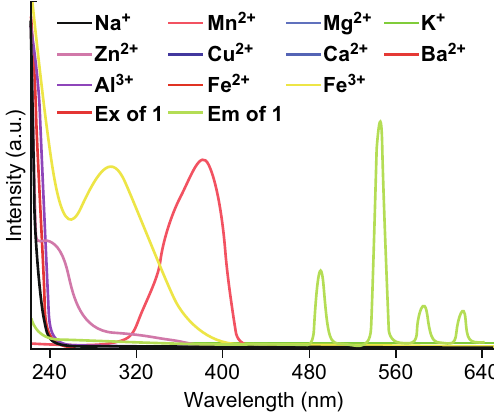
Fig. 20 The emission ( λ ex = 380 nm) and excitation ( λ em = 545 nm) spectra of {[Tb(Cmdcp)(H 2 O) 3 ] 2 (NO 3 ) 2 ·5H 2 O} n , as well as the absorption spectra of different metal ions. Reproduced with